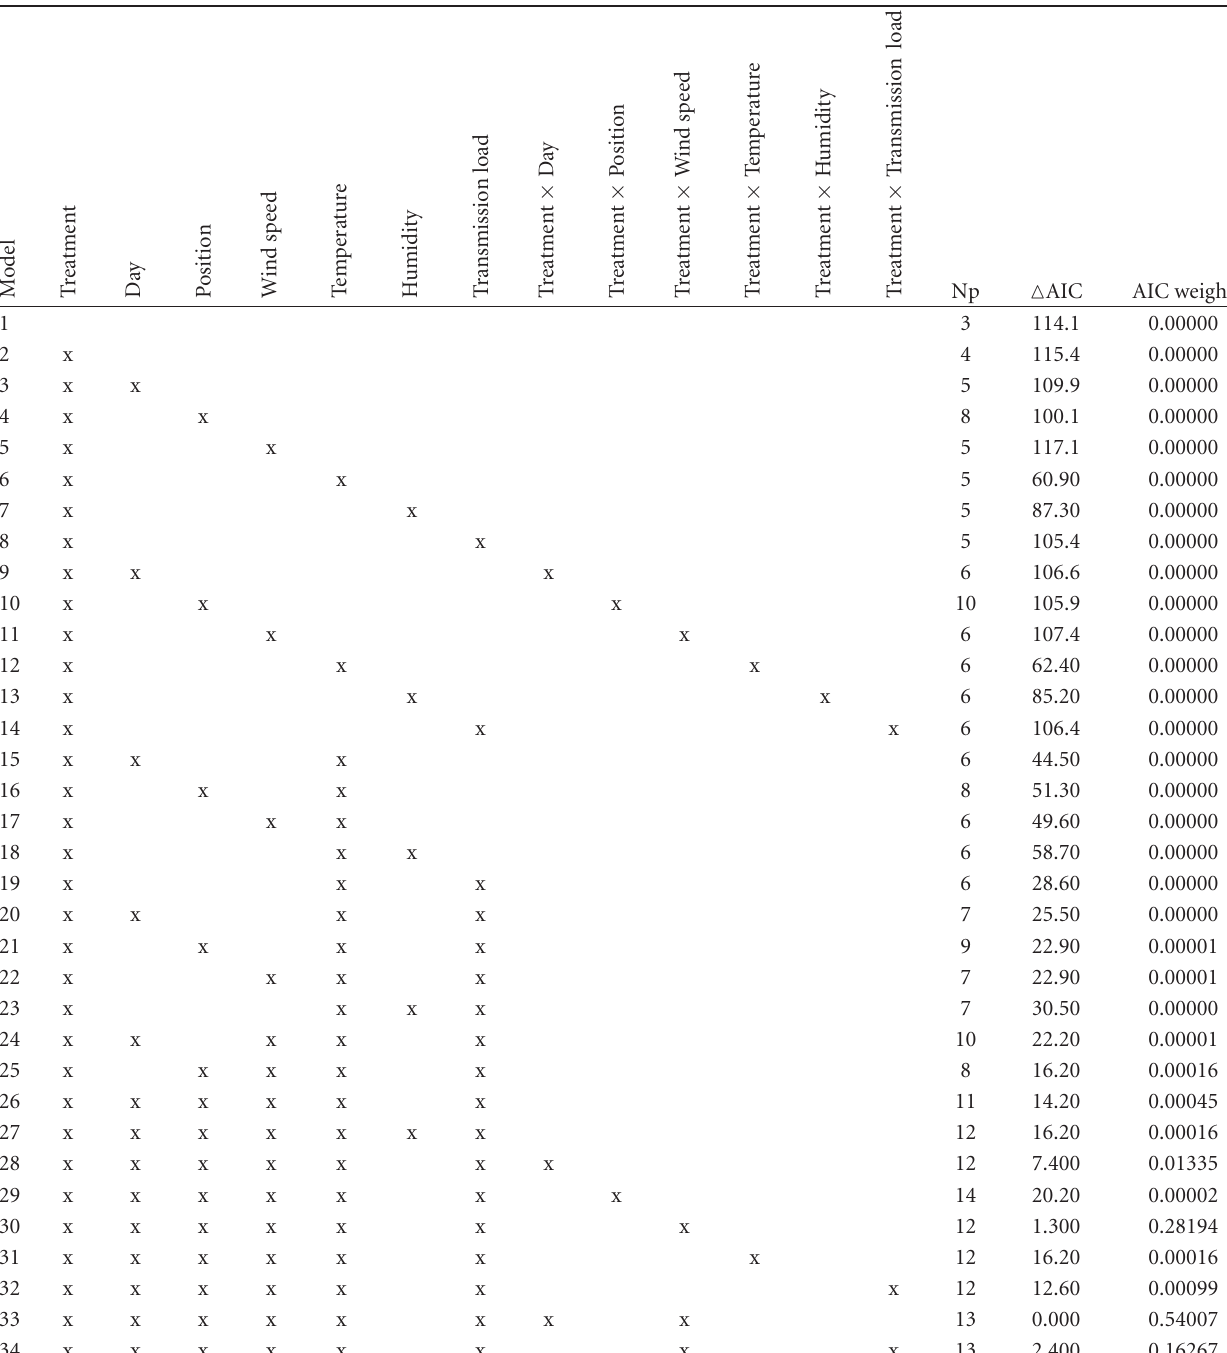
Table 5: Results from model selection on restless behaviour among domestic tame animals using the AIC criterion (Np is number of